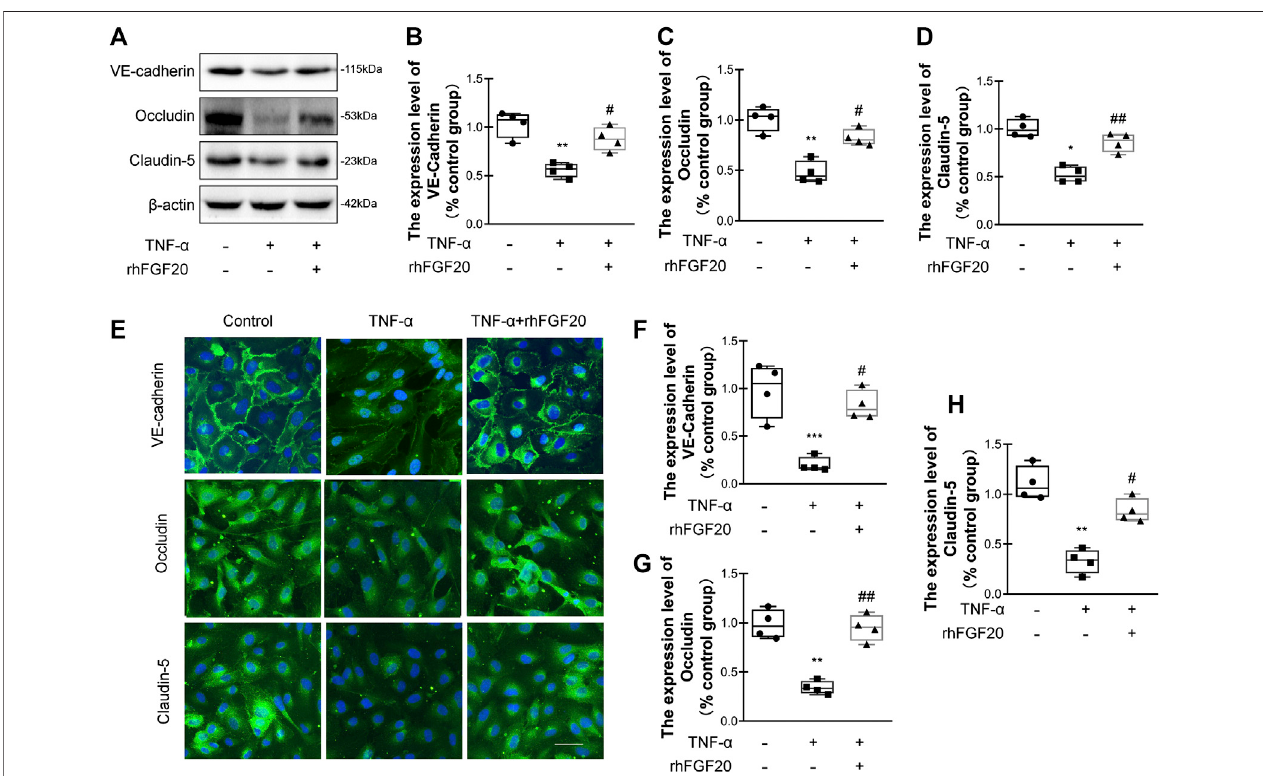
FIGURE 7 | rhFGF20 protected against TNF- α -induced BBB injury by increasing junction protein expression (A) Effects of rhFGF20 on the expression of VE- cadherin, Occludin, and Claudin-5, as assessed by western blot analysis of total cellular protein. β -Actin was used as the loading control and for band density normalization (B – D) Effects of rhFGF20 on VE-cadherin, Occludin, and Claudin-5 protein levels, as analyzed by quanti fi cation of western blot data ( n (cid:1) 4) (E) Effects of rhFGF20 on the expression of VE-cadherin, Occludin, and Claudin-5. Nuclei are labeled with DAPI (F – H) Effects of rhFGF20 on VE-cadherin, Occludin, and Claudin-5proteinlevels,asanalyzedbyquanti fi cationofimmuno fl uorescencestainingdata( n (cid:1) 4).Bar,50 μ m.Magni fi cation, × 40.* p < 0.05,** p < 0.01,*** p < 0.001vs. the control group. # p < 0.05, ## p < 0.01 vs. the TNF- α group. Data are presented as the mean values ±